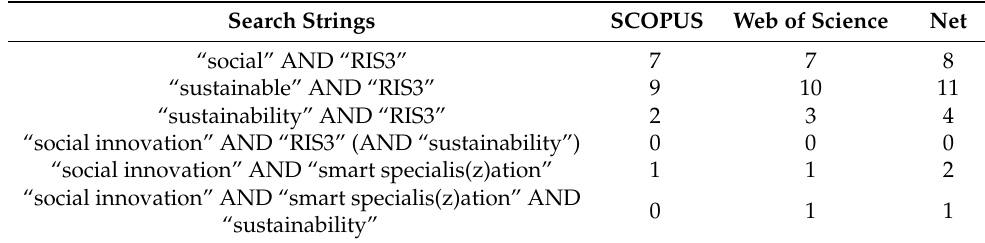
Table 3. Keywords and quantification of literature in SCOPUS and Web of Science databases using exclusion and inclusion criteria.